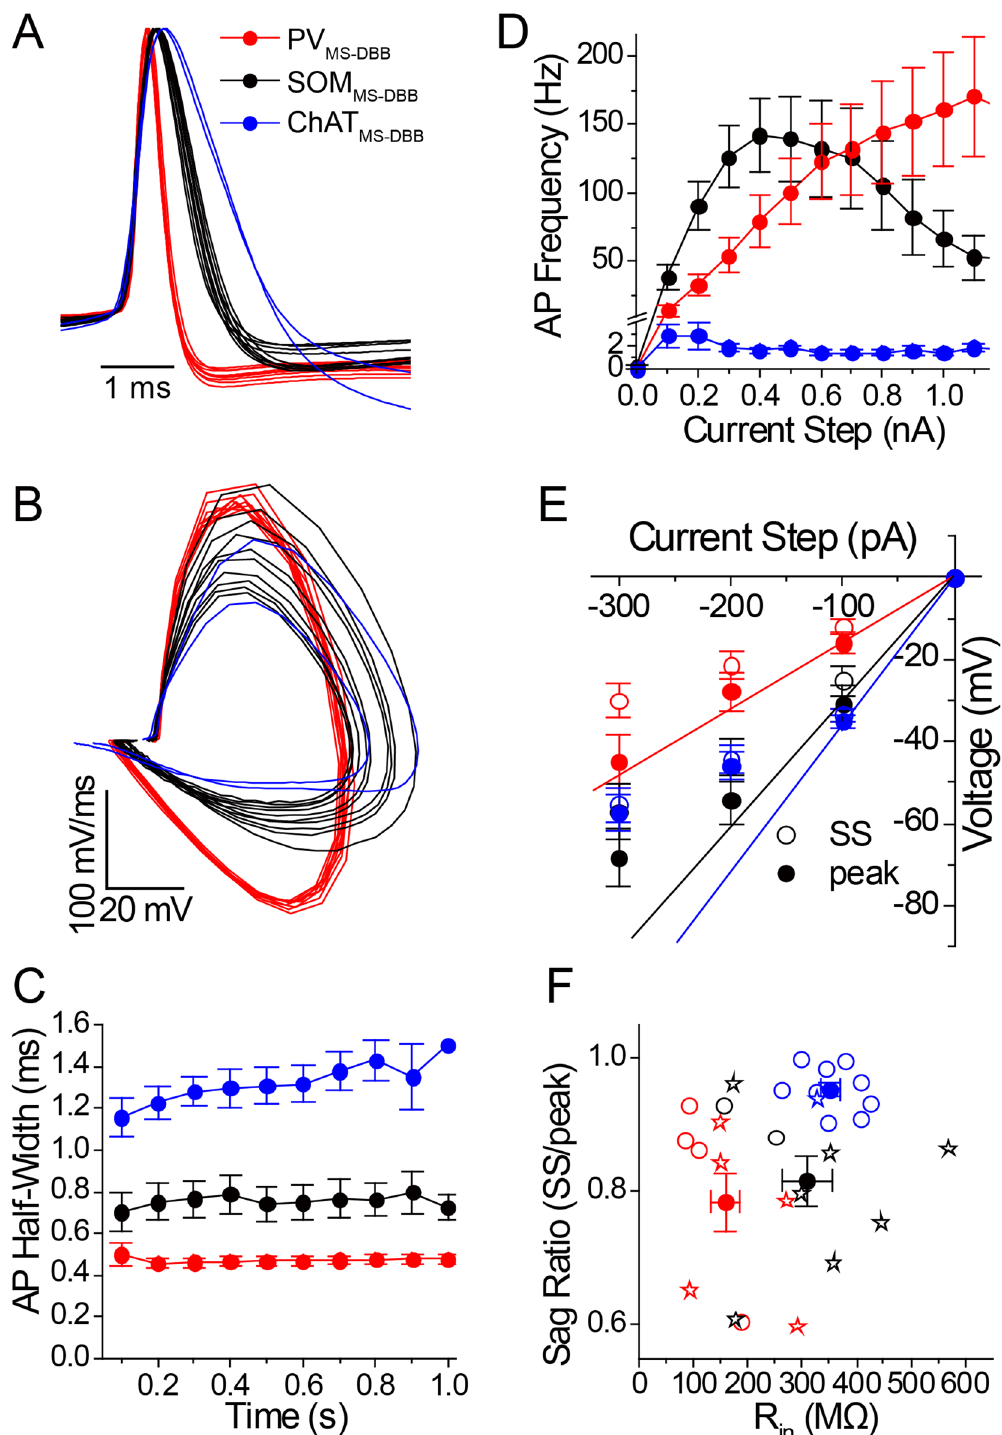
Figure 2. PV MS-DBB neurons are distinct from SOM MS-DBB and ChAT MS-DBB neurons. Overlaid are ( A ) normalized AP waveforms and ( B ) phase plots of APs of representative PV MS-DBB (red), SOM MS-DBB (black) and ChAT MS-DBB (blue) neurons. ( C ) AP half-width measurements during a 1 s long current step (+400 pA for PV MS-DBB and SOM MS-DBB cells; +100 pA for ChAT MS-DBB cells; 0.1 s bin). ( D ) Average AP frequencies generated in response to 1 s long, +100–1200 pA current steps from −60 mV. ( E ) Peak (closed circles) and steady-state (SS; open symbols) voltage responses to 1 s long −100 to −300 pA from −60 mV. To reveal rectification of voltage responses, Ohmic linear regression lines from zero to the peak voltage response at the −100 pA current step are shown. ( F ) A plot of sag ratio (SS/peak) vs. input resistance ( R in ) distinguishes neurochemically distinct MS-DBB cell types. Open and closed symbols denote individual cells and population means, respectively. Open stars indicate neurons that exhibited hyperpolarization-induced rebound